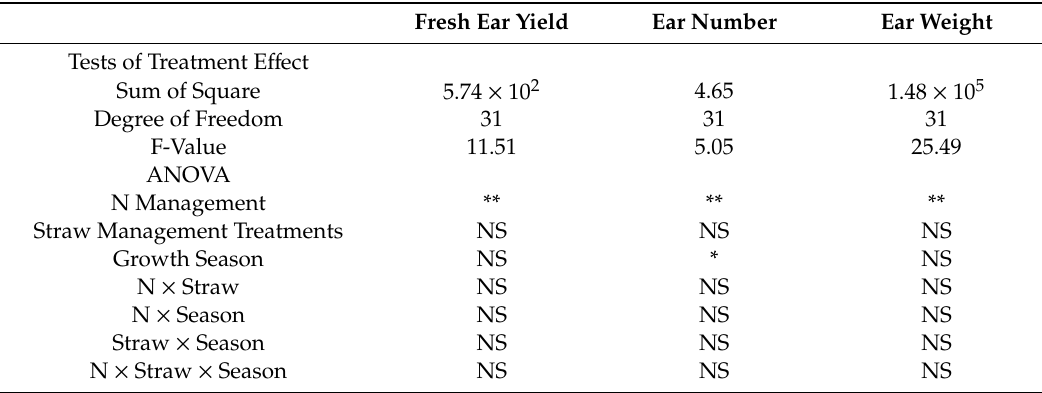
Table 4. Analysis of variance for the fresh ear yield, ear number and ear weight of sweet corn. Levels of significance indicated as: NS = not significant. * Significant at p ≤ 0.05; ** Significant at p ≤